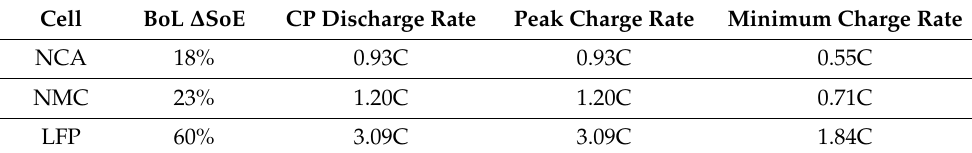
Table 2. ∆ SoE and approximate cycling rates for each cell type during accelerated LEO cycling. Cell BoL ∆ SoE CP Discharge Rate Peak Charge Rate Minimum Charge Rate NCA 18% 0.93C